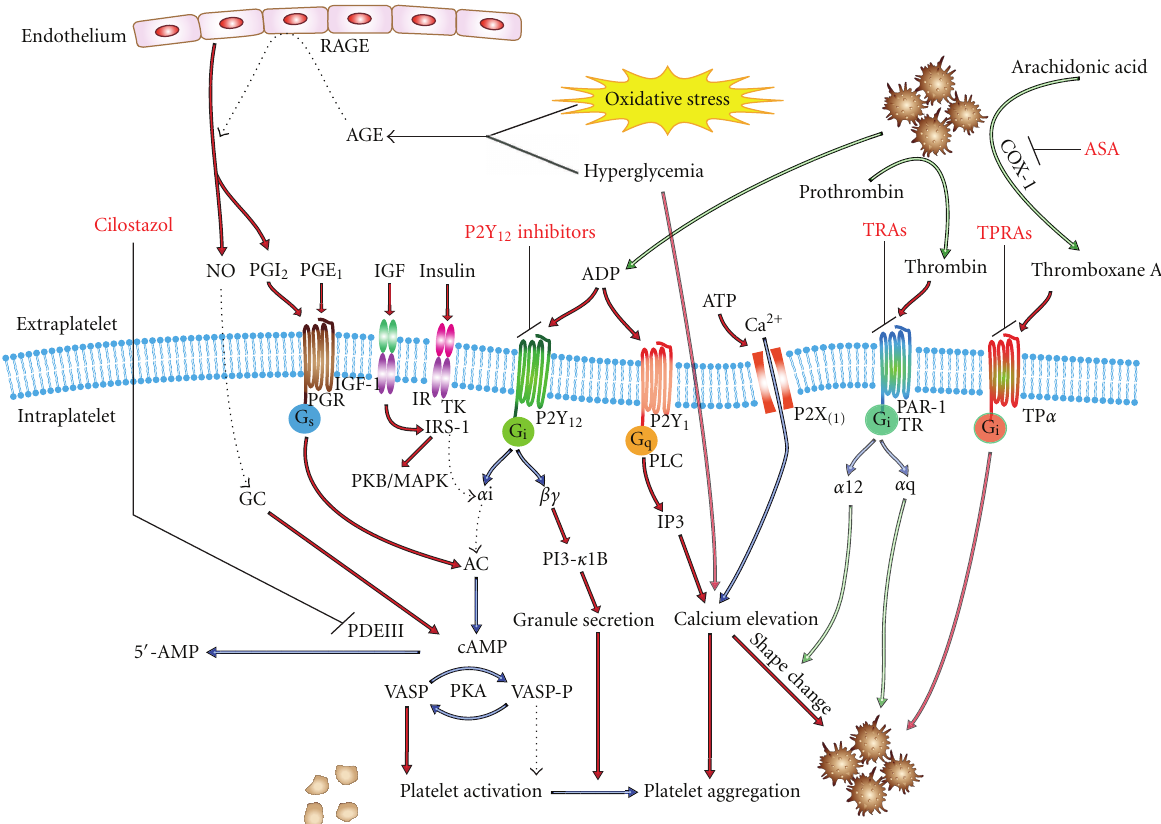
Figure 1: Pathways involved in platelet hyperreactivity in DM patients and therapeutic targets. AGE: advanced glycation end products, RAGE: AGE receptors, PKA/B/C: protein kinase A/B/C, MAPK: p38 mitogen-activated protein kinase, TK: tyrosine kinase, NO: nitric oxide, GC: guanylate cyclase, PAR-1 TR: protease activated receptor; thrombin receptor, PI-3: phosphoinositol-3 kinase TRA: thrombin receptor antagonist, TP α : thromboxane receptor, TPRA: thromboxane receptor antagonist, and ASA: acetylsalicylic acid (aspirin). Increased levels of cAMP lead to platelet inhibition through cAMP-dependent protein kinase (PKA) which inhibits signaling though the mitogen-activated protein kinases pathway, receptor activation, thromboxane A2 formation, and activation of key enzymes such as protein kinase C. The prostaglandin, P2Y, P2X, TR, and TP are all seven transmembrane G-protein associated receptors. The TR and TP on the right present novel drug targets; their intracellular e ff ectors are omitted for clarity. Antiplatelet drugs are shown in